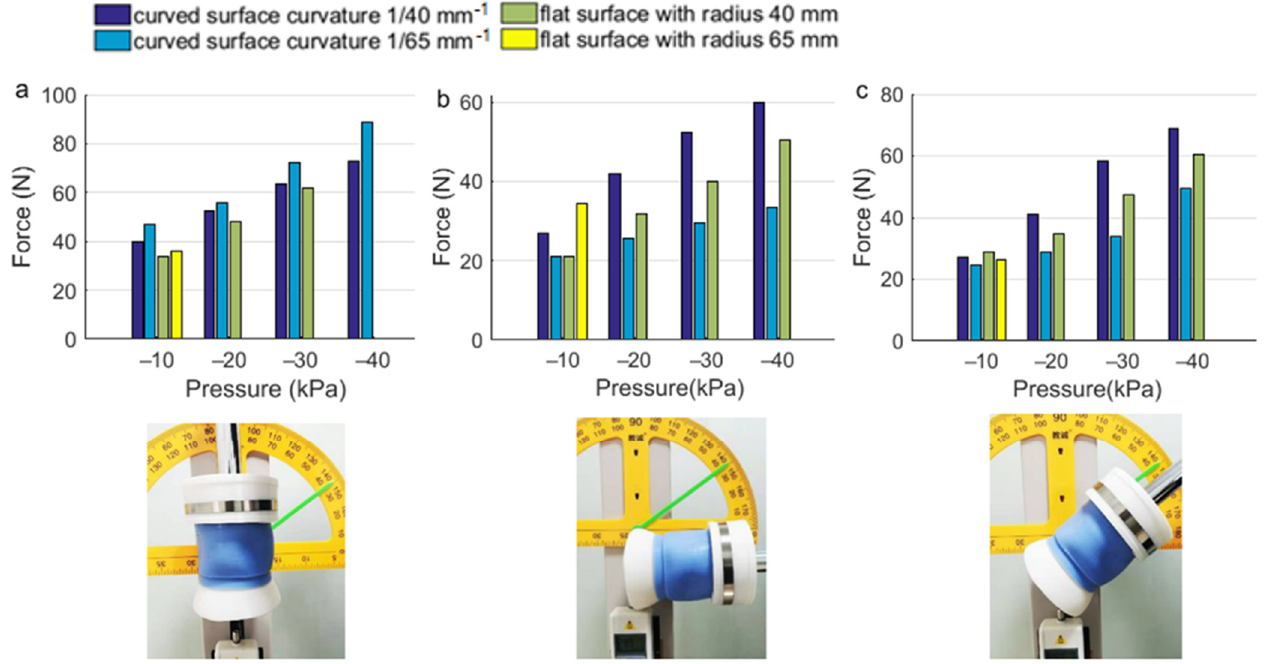
Figure 10. Adsorption forces of the cylindrical soft actuator. ( a ) The cylindrical soft actuator adsorbs objects in the vertical orientation. ( b ) The cylindrical soft actuator adsorbs objects in the horizontal orientation. ( c ) The cylindrical soft actuator adsorbs objects in the inclined